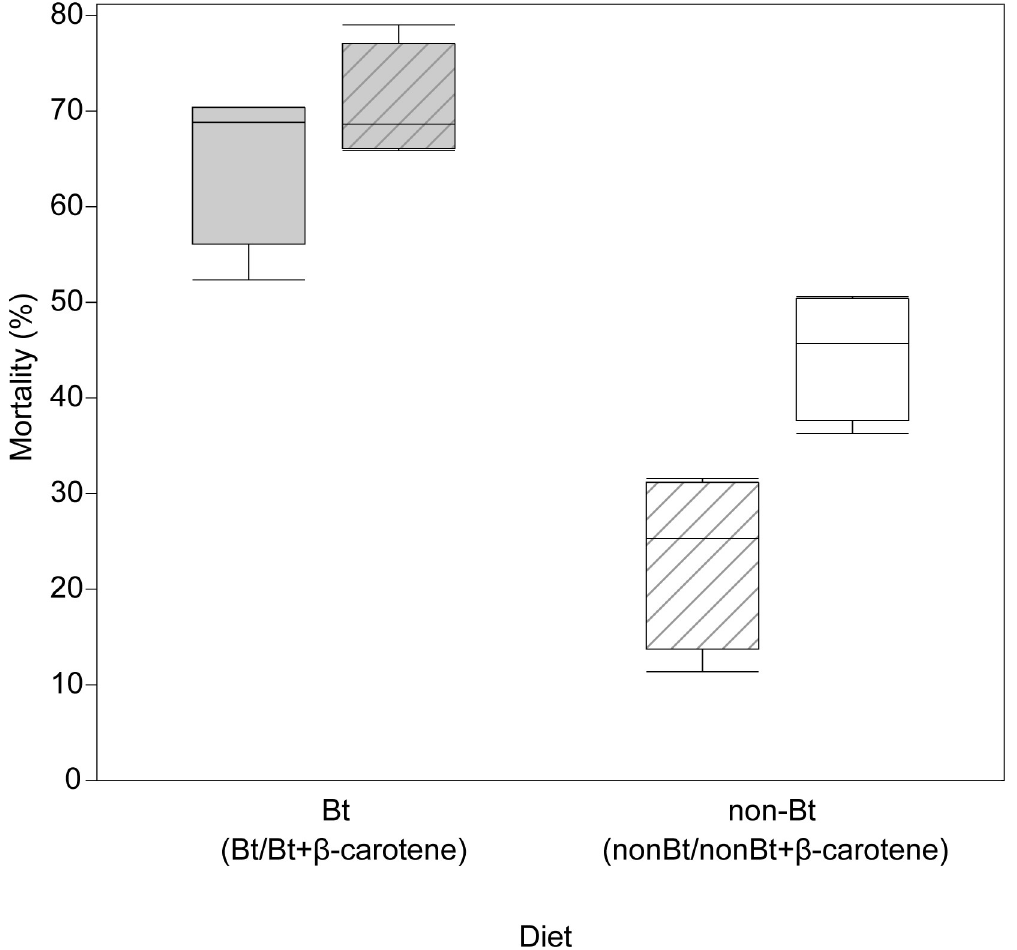
Fig 7. Mortality of Helicoverpa armigera F2 larvae. Percentage of the mortality of F2 larvae fed on Bt or non-Bt diets. The grey boxplots indicate F2 diets with Bt toxin; white boxplots indicate non-Bt diets. The lined grey boxplot indicates F2 larvae fed on Bt diet descending from F1 larvae fed on non-Bt diet; the lined white boxplot indicates F2 larvae fed on non-Bt diet descending from F1 larvae fed on Bt diet. As the presence of β -carotene had no effects on mortality percentage, columns Bt include Bt and Bt+ β -carotene results and columns non-Bt include non-Bt and non-Bt+ β -carotene results.